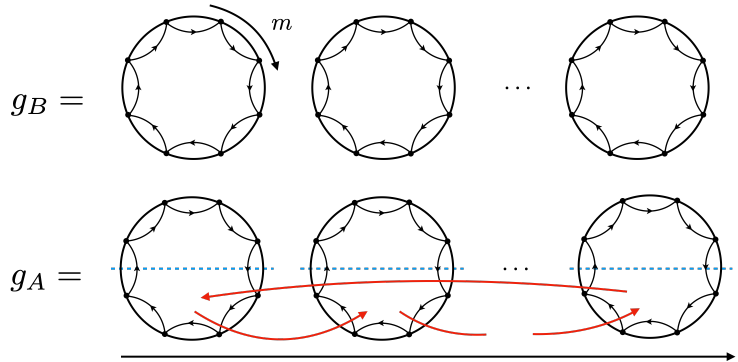
Figure 7 . A graphical representation of the elements g A and g B . Each circle represents m replicas of the original tensor and each circle is replicated n times. A cycle of the permutation is represented by a directed closed loop. The element g is a product of individual cyclic permutations τ on B m each circle. The element g is additionally conjugated by the twist operator γ (indicated by red A τ arrows) whose action can be thought of as slicing each circle in half and shifting the lower half in an n -cyclic